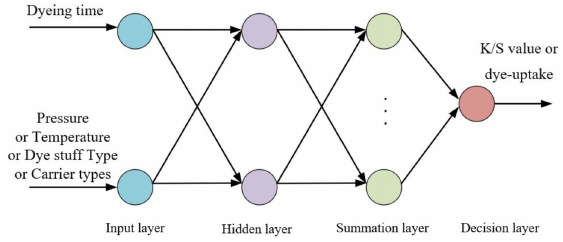
Figure 1. Schematic architecture of the designed Generalized Regression Neural Network (GRNN) model.